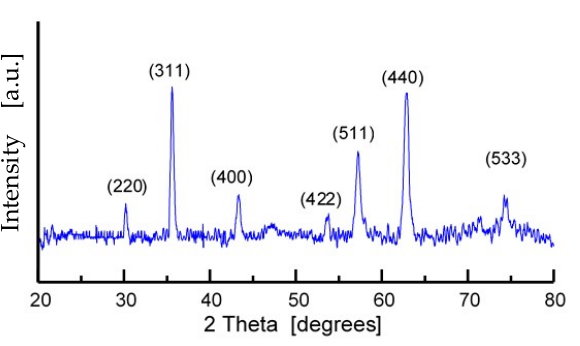
Figure 1. SEM ( A ) and TEM ( B ) images of maghemite nanoparticles, magnetization versus applied field ( C ), and the bandgap of maghemite nanoparticles ( D ).